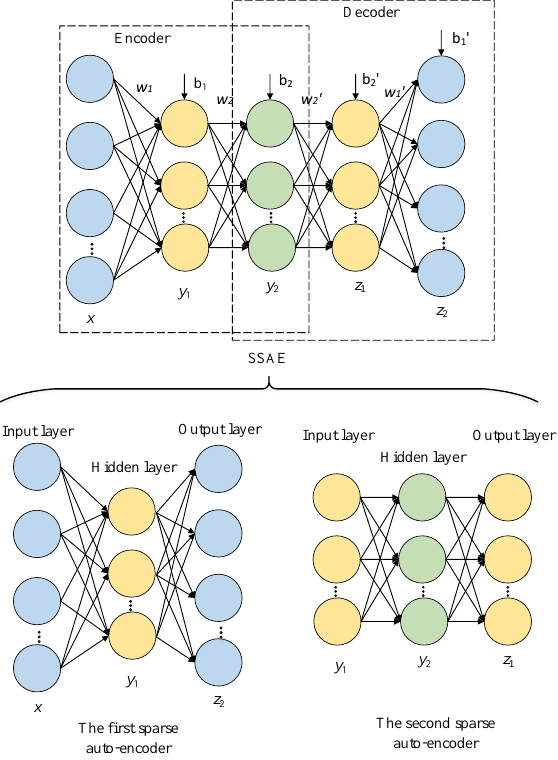
Figure 2. A stacked sparse auto encoder (SSAE) network composed of two sparse auto-encoders.